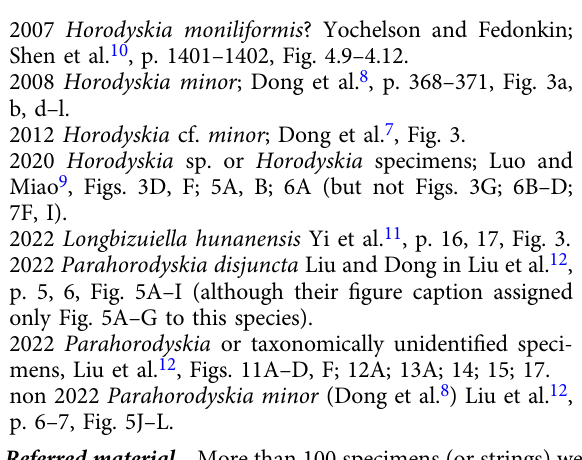
Fig. 3 Horodyskia moniliformis from the Tonian Shiwangzhuang Formation. Most beads of H. moniliformis are not enveloped in a halo, although a few are surrounded by a faint halo. a A long and sinuous specimen of H. moniliformis preserved together with a specimen of Protoarenicola baiguashanensis (arrowhead) and an unidenti fi ed fi lamentous fossil (arrow); SWZ-CZ-47-1. b Magni fi cation of box area in a ; arrow denotes a bead with a septum, possibly in division. c – n Specimens with various bead shapes and varying degrees of string curvature. c SEM image of box area in d , showing shallow impression of bead preserved as a negative relief. e Arrow denotes a dumb-bell shaped bead likely in division. g , h Magni fi cations of box areas in f ; arrows denote concentric thickening. i A specimen consisting of beads with irregular (upper arrow) and concentric (lower arrow) thickening. j A specimen of H. moniliformis preserved together with fi lamentous fossils (arrowhead); arrow denotes a bead and a fi lamentous fossil overlapped with organic fi lm. d SWZ- CZ-21; e SWZ-CZ-54; f SWZ-CZ-40; i SWZ-CZ-30; j SWZ-CZ-47-2; k SWZ-CZ-19; ( l ) SWZ-CZ-43; m SWZ-CZ-51; n SWZ-CZ-31. o , p Part and counterpart; beads are preserved as negative relief on sole bedding surface ( o ) and positive relief on top bedding surface ( p ); SWZ-CZ-58. All sub fi gures are images on top bedding surface, except otherwise marked, under re fl ected light microscopy ( a , b , d – p ; RLM) or SEM (